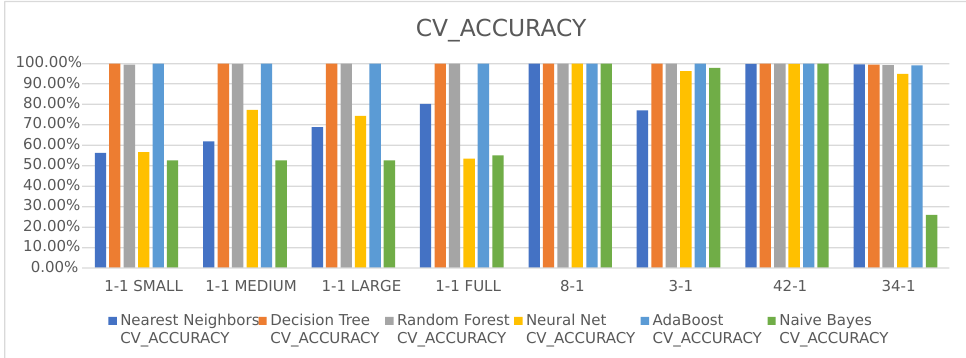
Figure 10. Accuracy of techniques per